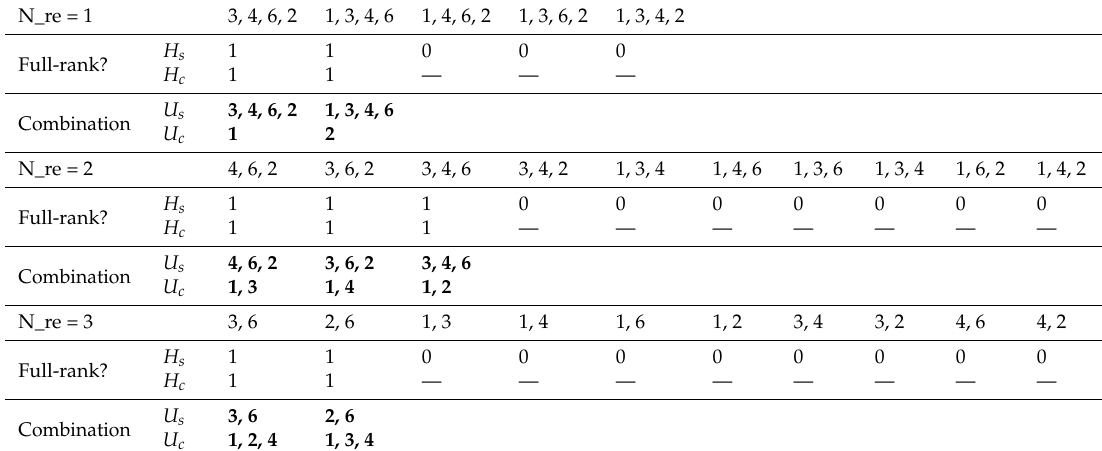
Table 6. The process of replacing scanning with counting in Figure 1